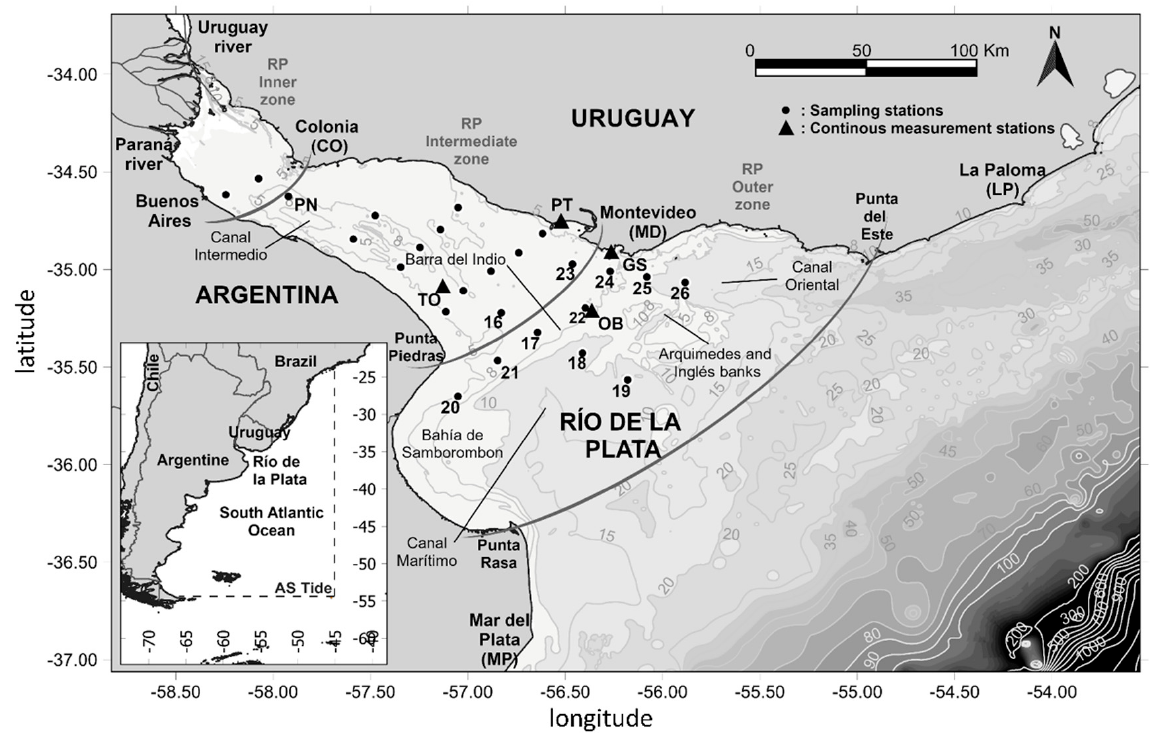
Figure 1. Río de la Plata: location and bathymetry (in m), as well as main geographical and morphological references. CTD vertical profile stations (numbered dots 16–25) and continuous salinity measurement deployment stations (triangles TO and OB), collected from during the FREEPLATA–FEEM project, are shown.